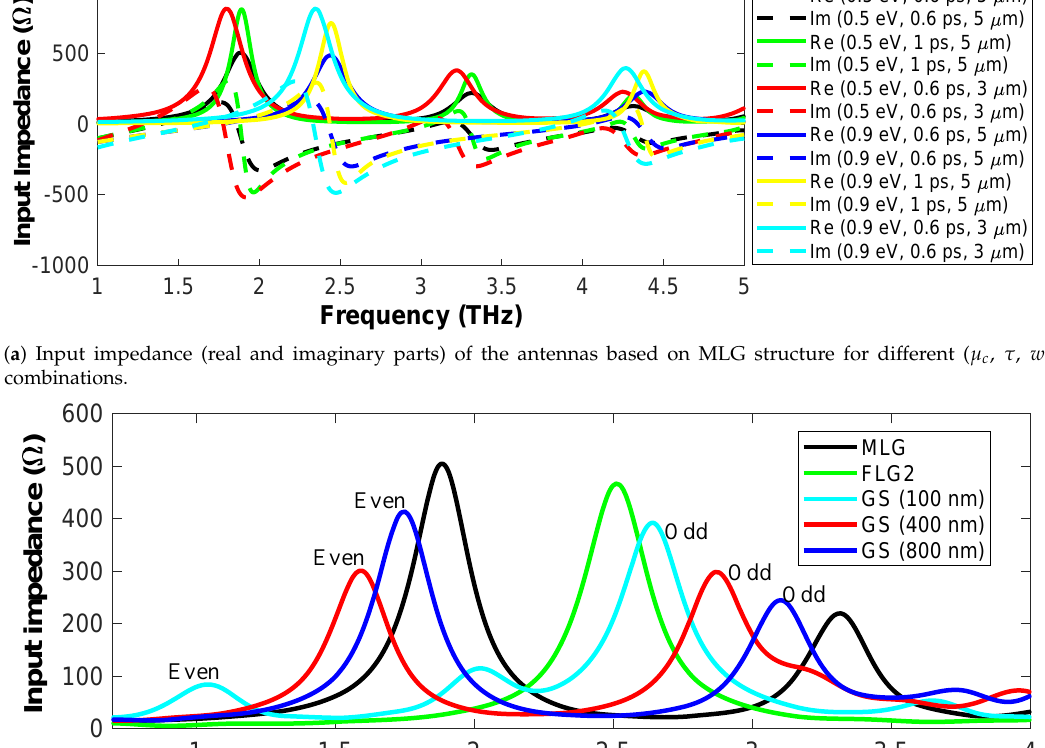
Figure 4. Input impedance characterization of the proposed antenna structure.